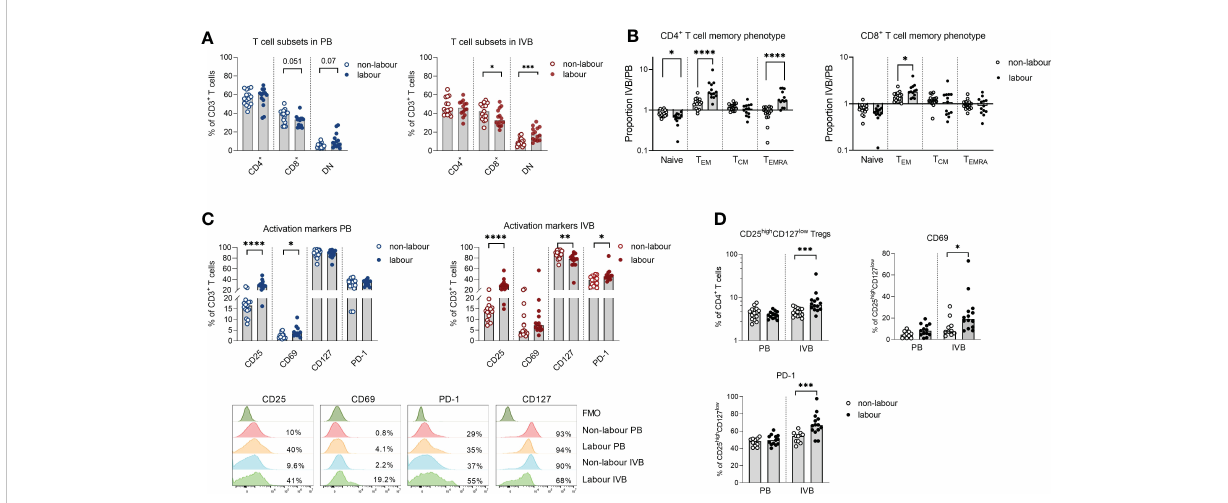
FIGURE 4 Labour leads to a relocation of T EM cells from the circulation to the intervillous space and promotes a more activated phenotype in T cells. (A) Flow cytometric determination of proportions of CD4 + , CD8 + and double negative (DN) cells out of the CD3 + cell population in peripheral blood (PB) and intervillous blood (IVB) from women delivering with labour (n=14) or without labour (n=15). (B) Relative proportions of naïve, effector memory (T EM ) central memory (T CM ) and terminally differentiated (T EMRA ) cells out of CD4 + and CD8 + T cells in labour compared to non-labour. (C) Expression of CD25, CD69, CD127 and PD-1 on CD3 + T cells from PB and IVB from women delivering without and with labour (top) and representative fl ow cytometry stainings (bottom). (D) Proportion CD25 bright CD127 low T cells out of CD4 + T cells and proportions of CD69 and PD-1 positive cells out of the CD25 bright CD127 low in PB and IVB from labour or non-labour. Data is presented as median and statistical differences were determined with Mann Whitney test, *p<0.05, **p<0.01, ***p<0.001,